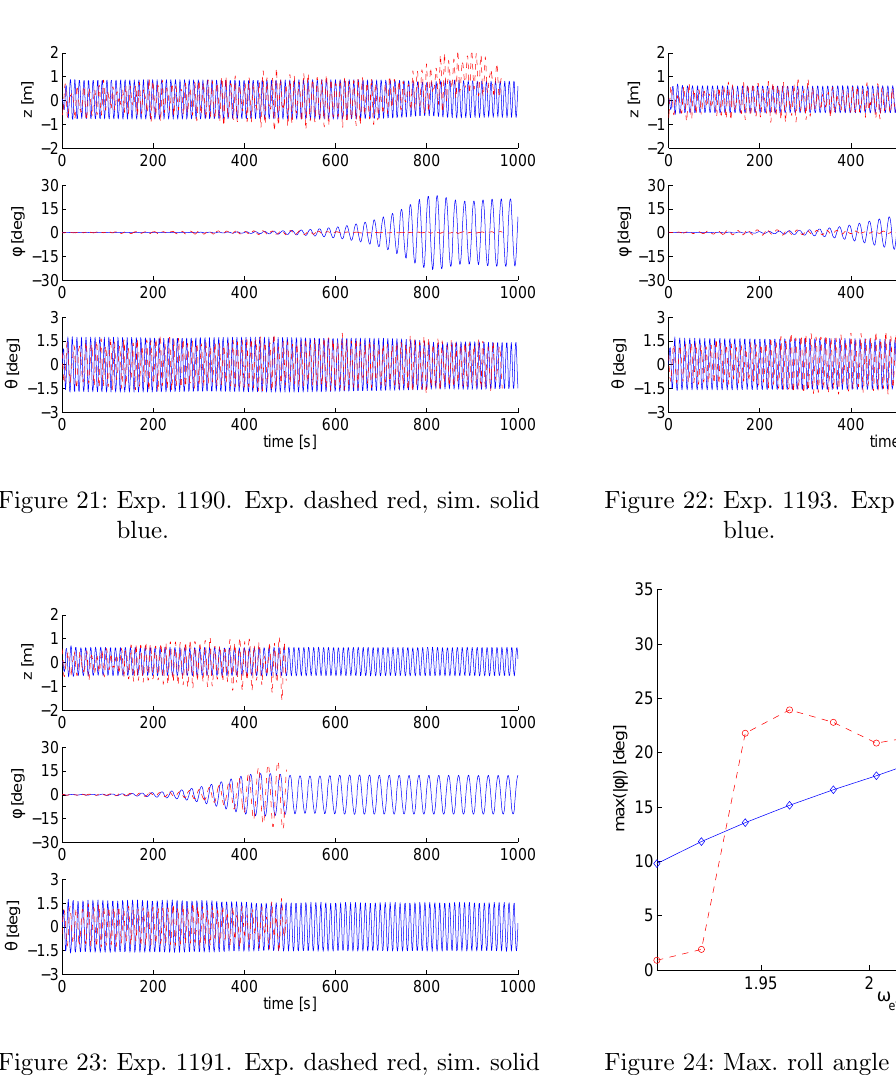
Figure 23: Exp. 1191. Exp. dashed red, sim. solid blue.